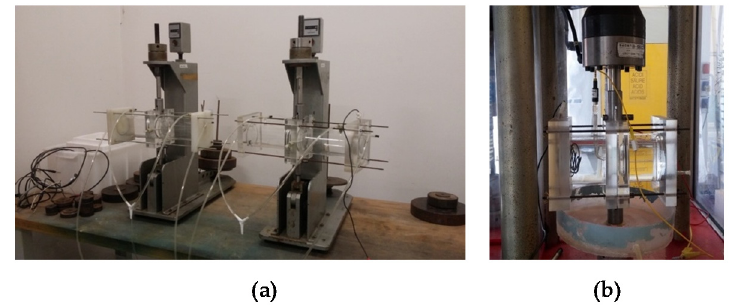
Figure 3. CL test device ( a ) and SSR test device ( b ).